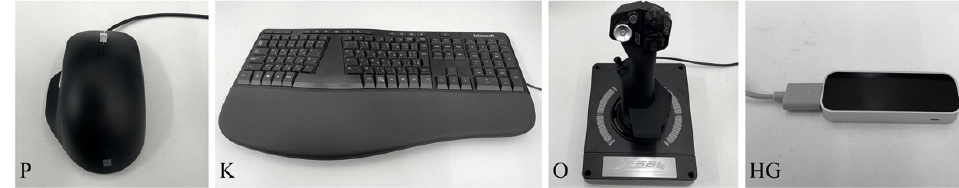
Figure 5. Input devices. (P) Pointing device. (K) Keyboard. (O) Orientation. (HG) Hand-free gesture.